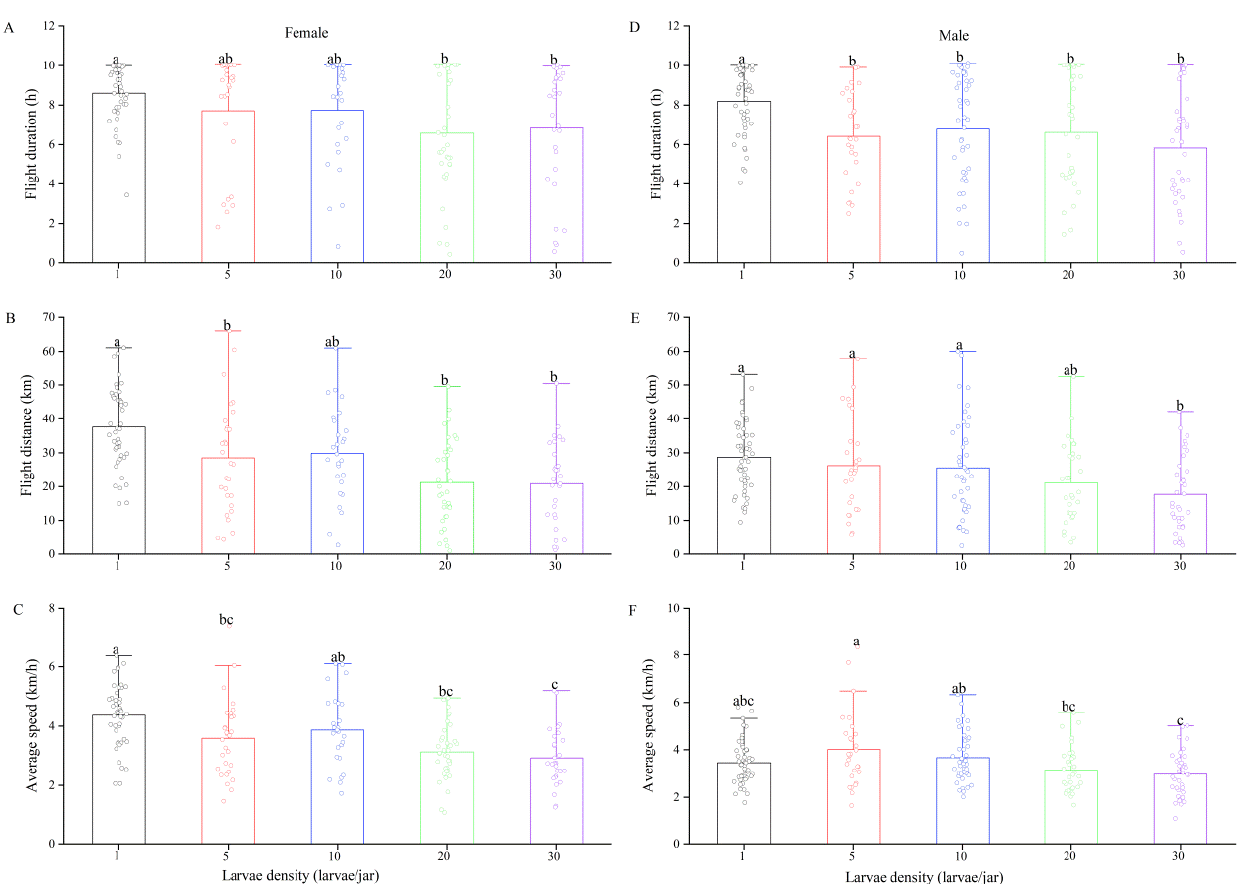
Figure 3. Flight duration ( A : females, D : males), flight distance ( B : females, E : males) and flight velocity ( C : females, F : males) of Spodoptera frugiperda adults under different larval densities. Different letters above group bars indicate significant differences among different larvae densities (1-way ANOVA: p < 0.05). Sample sizes for female moths were 45, 29, 27, 36, 29 from left to right; the sample sizes of male worms were 49, 28, 43, 32 and 36.